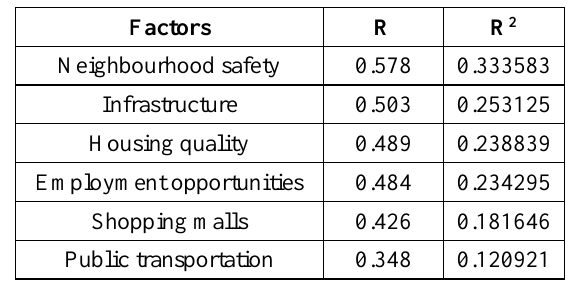
Table 2. Six Factors Most Affecting Rental Levels in Neighbourhoods of Riga (developed by the authors, based on Renting prices, Riga City Council